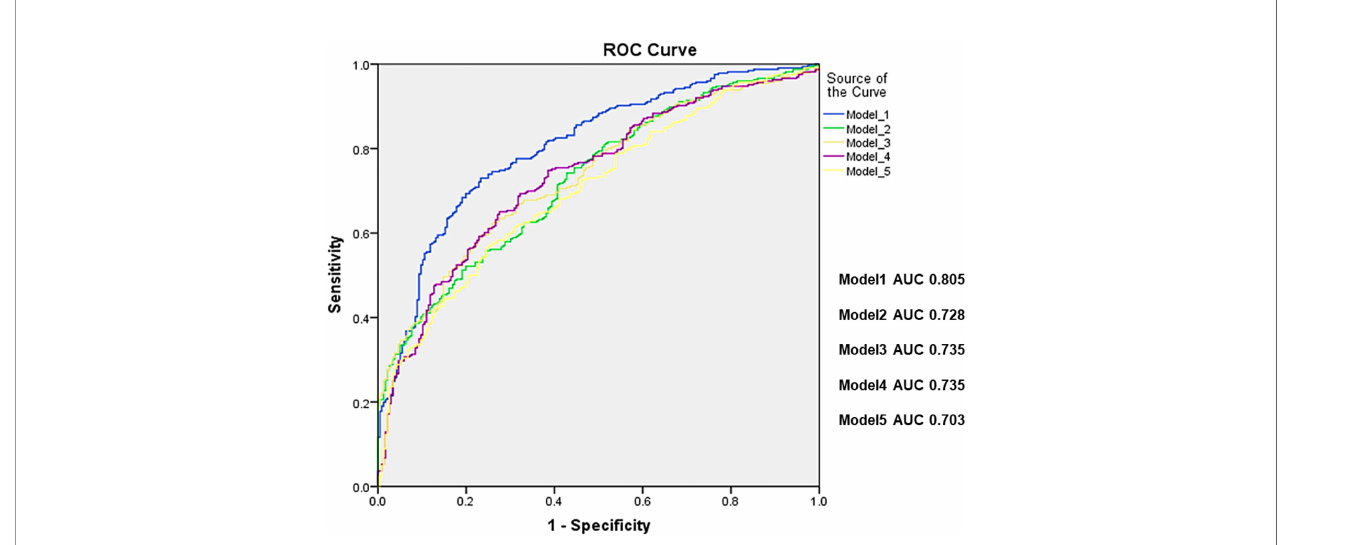
FIGURE 3 | Receiver operating characteristic curves (ROC) for standard models alone (Model 1: THCortThick +HeadVol+THRCTM +FNCSA, Model 2: THCortThick +HeadVol+FNCSA, Model 3: ITCortThick+HeadVol+FNCSA, Model 4: ITCortThick+HeadVol, and model 5: ITCortThick+FNCSA. All 5 models were adjusted for age, height and weight, respectively, and the p values for all models were <0.001. TH, total hip; CortThick, cortical thickness; HeadVol, femoral head volume; RTHCTM, ratio of total hip Cortical/Trabecular Mass; FNCSA, femoral neck cross-sectional area; IT,